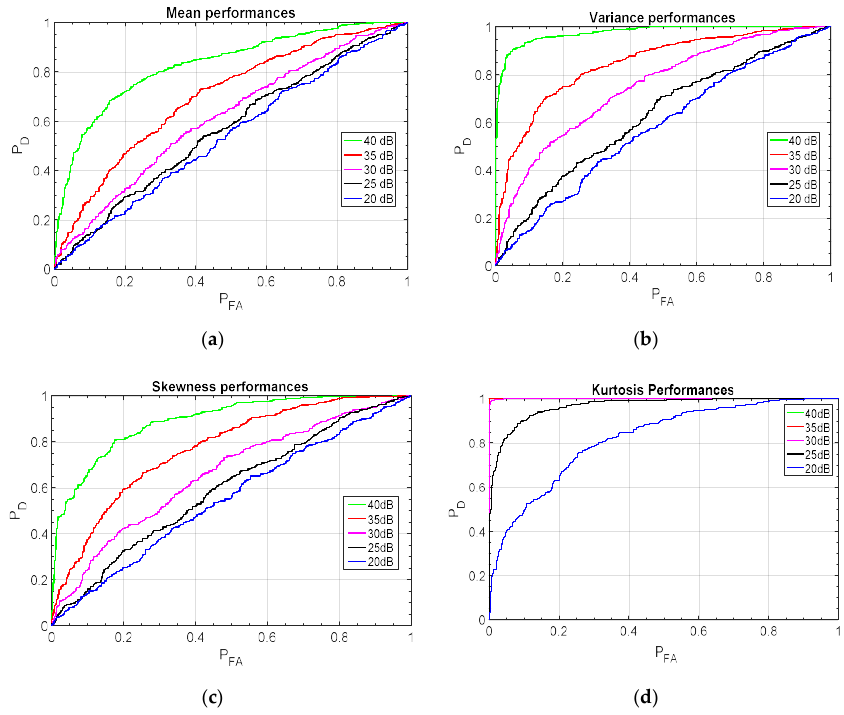
Figure 9. Open switch fault (duration 100 µs) detection performance for 60 rad/s at rated torque: ( a ) With mean value, ( b ) With variance, ( c ) With Skewness, ( d ) With Kurtosis. Energies 2019 , 12 , x FOR PEER REVIEW